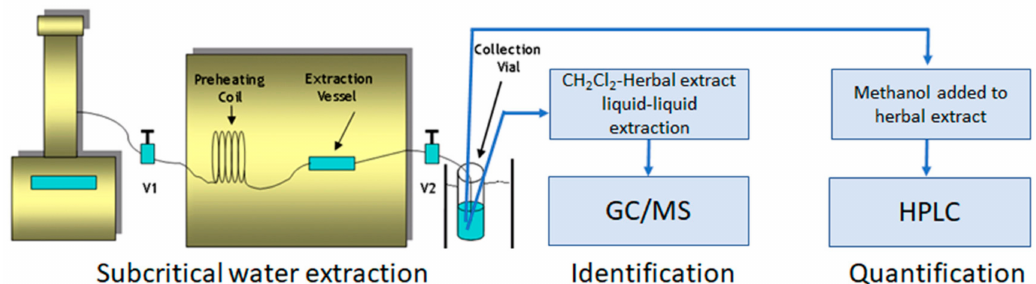
Figure 3. Block diagram of subcritical water extraction (V1 and V2 are needle valves) followed by GC/MS identification and HPLC quantification of